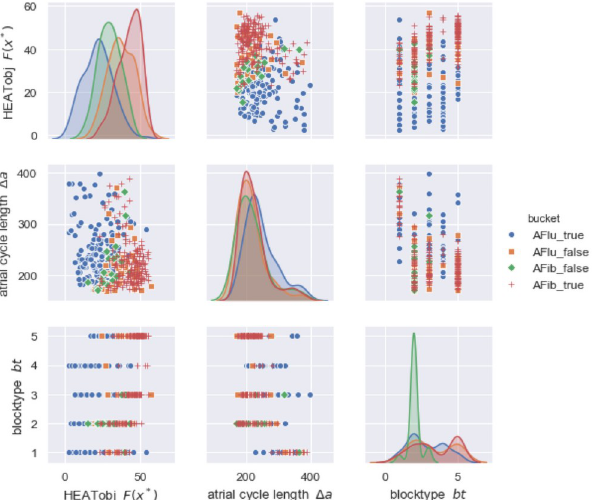
Fig 6. Representative pairwise plot of features obtained from a heatSolution SVM classification, compare Table 2.